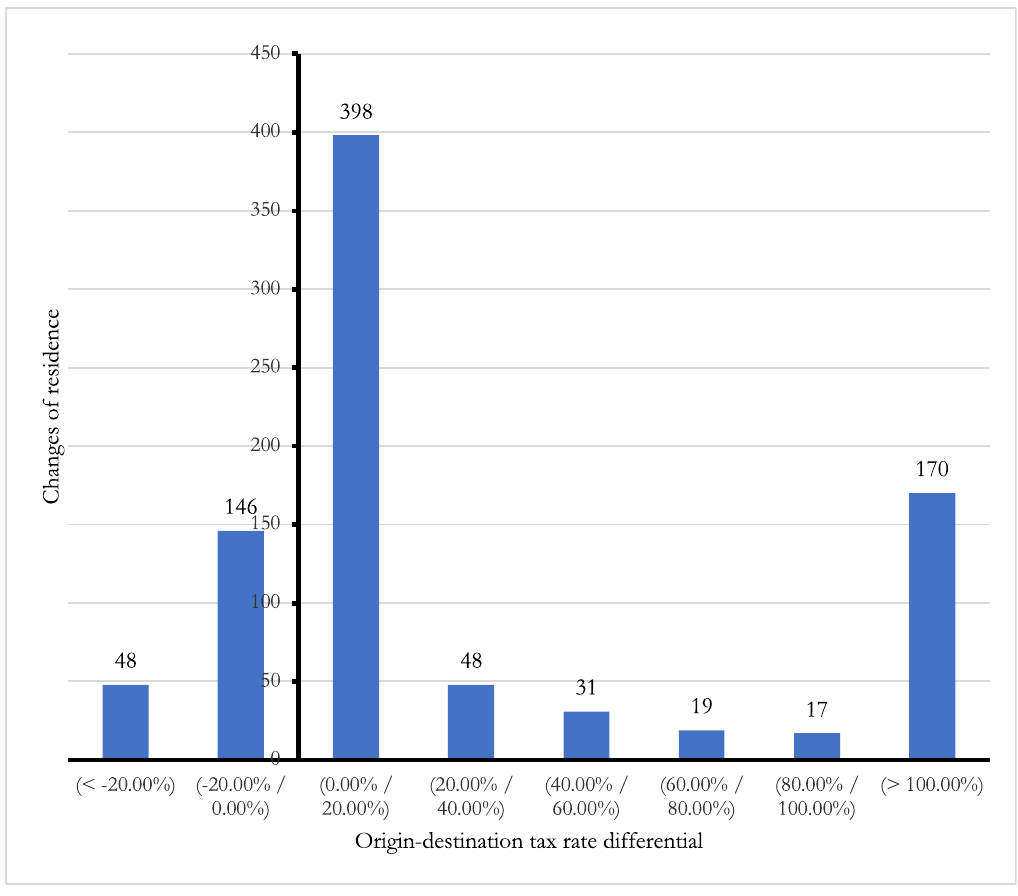
Figure 2: Distribution of changes of residence according to the di ff erence in capital taxation average rates between the communities of origin ( in 2006 ) and destination ( in 2012 )